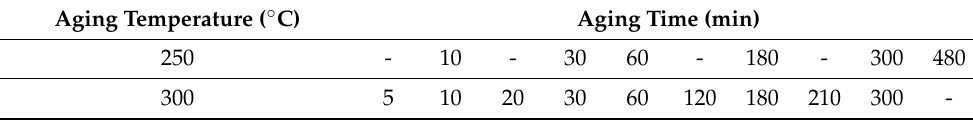
Table 1. High-temperature aging process of ZL205A alloy.